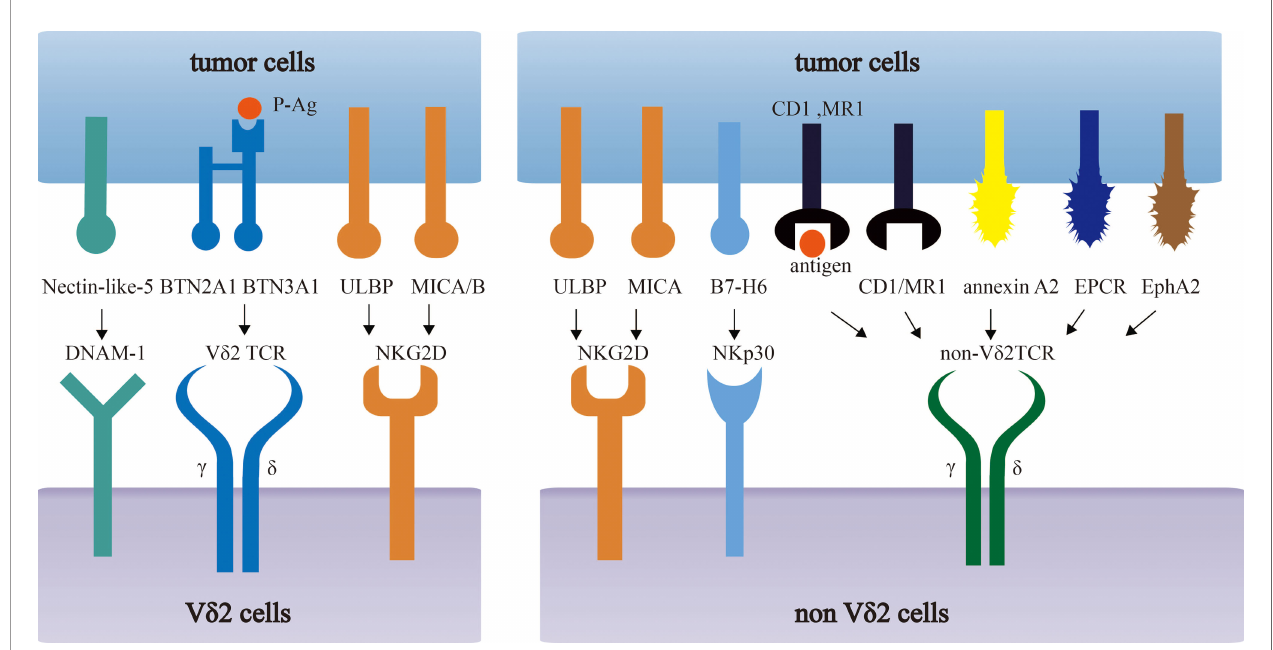
FIGURE 1 | Recognition of tumor-associated antigens (TAAs) by different subsets of gd T cells. V d 2 T cells recognize phosphoantigens (P-Ag) modi fi ed Butyrophilin 2A1 (BTN2A1)-Butyrophilin 3A1 (BTN3A1) complex. Non-V d 2 TCRs recognize CD1 family members and MR1 in either antigen dependent or independent manner. Besides, NK receptors (NKG2D, NKp30, DNAM-1) in gd T cells recognize MICA/B, ULBP and B7-H6, Nectin-like-5